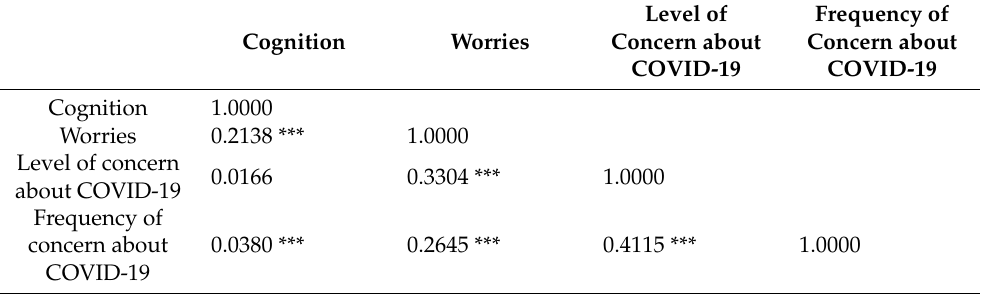
Table 2. Correlation